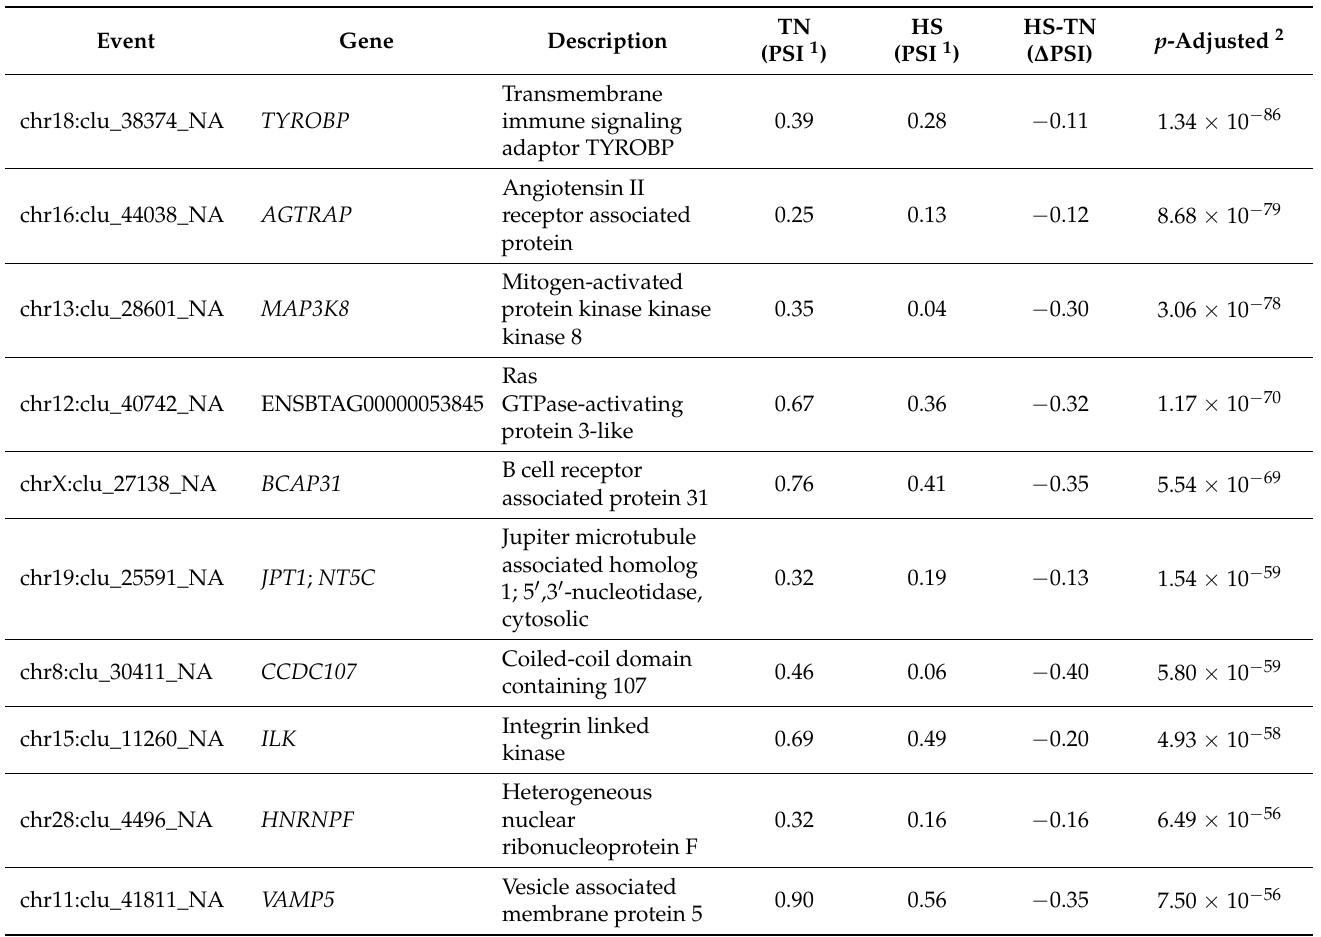
Table 2. The top 10 differential alternative splicing events between Holstein cows experiencing thermal neutrality (TN) and heat stress (HS)